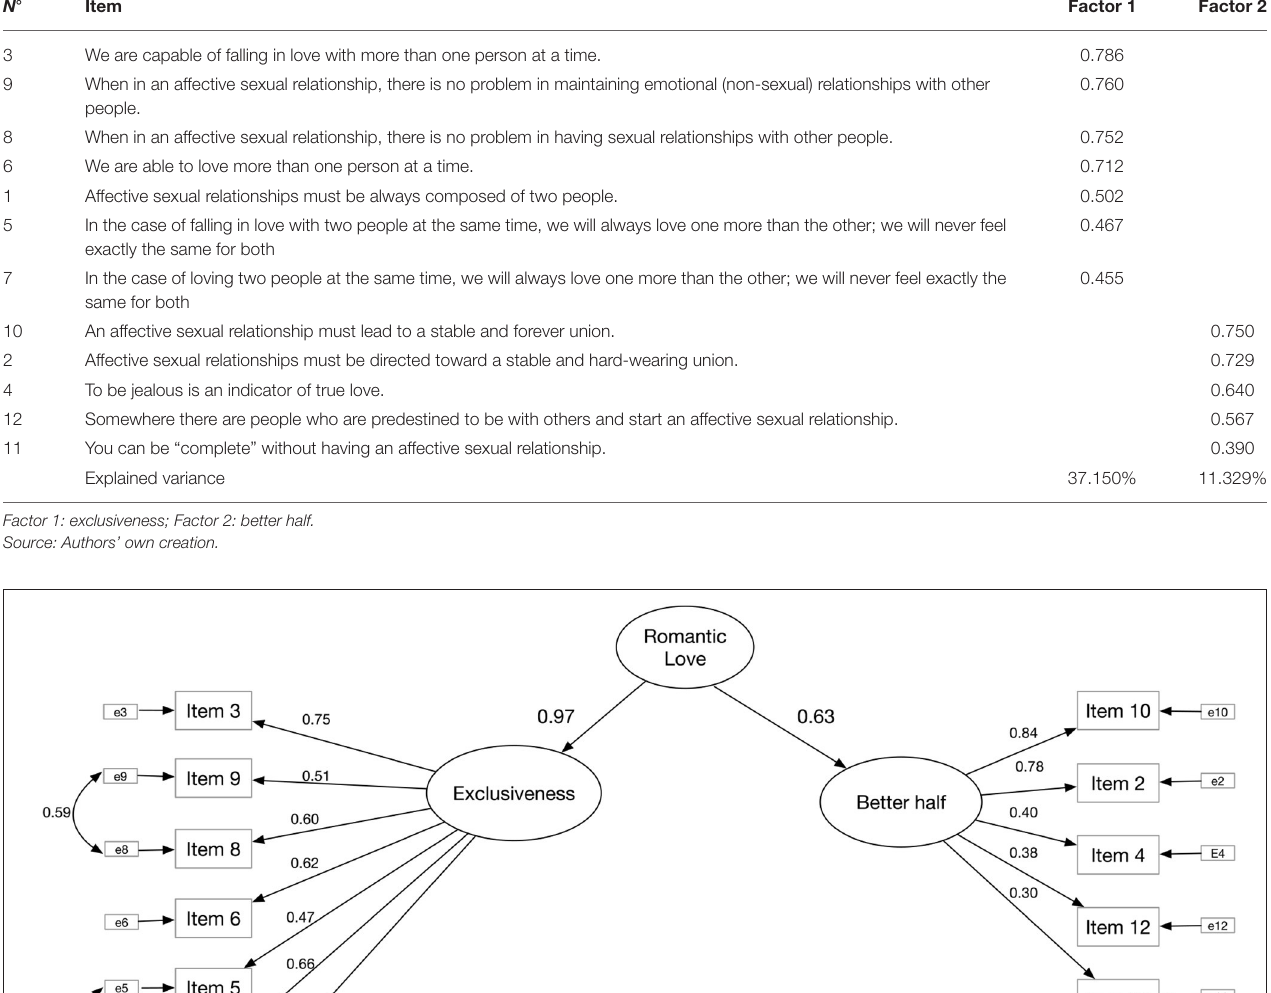
TABLE 1 | Factorial structure with EFA and the factor loads of the romantic love scale adapted to affective sexual diversity. N ◦ Item Factor 1 Factor 2 3 We are capable of falling in love with more than one person at a time.